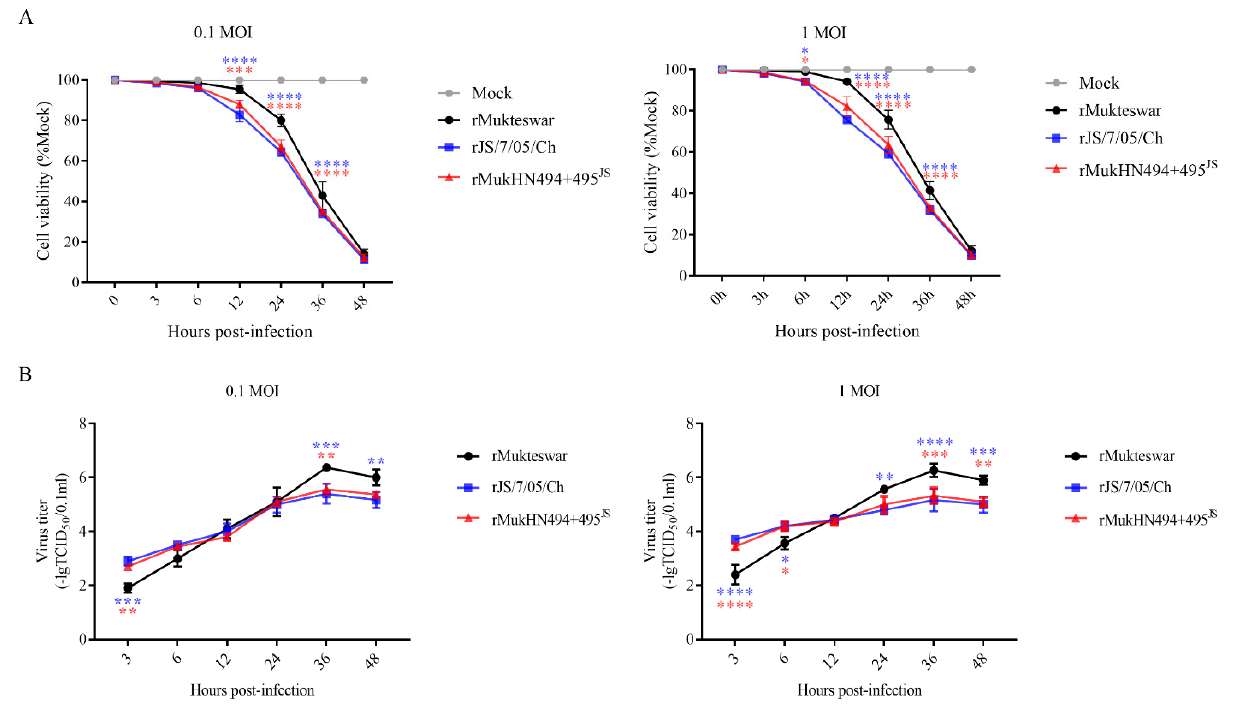
Figure 7. Evaluation of cell viability and virus replication ability in NDV-infected CEF cells. Three viruses were inoculated into CEF cells at 0.1 and 1 MOI, respectively. ( A ) Reduction of cell viability in NDV-infected CEF cells at 3, 6, 12, 24, 36, and 48 hpi. ( B ) Growth characteristics of the three vi- ruses were determined during 3–48 hpi. All values were compared with that of rMukteswar. * p < 0.05, ** p < 0.01, *** p < 0.001, and **** p < 0.0001.